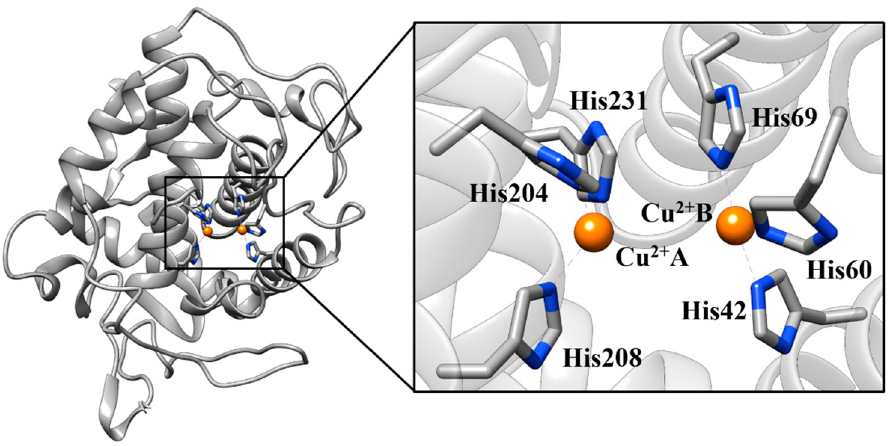
Figure 1. The catalytic site of tyrosinase (TYR) where Cu 2+ ions interact with key histidine residues (Protein Data Bank (PDB) code 5I38).